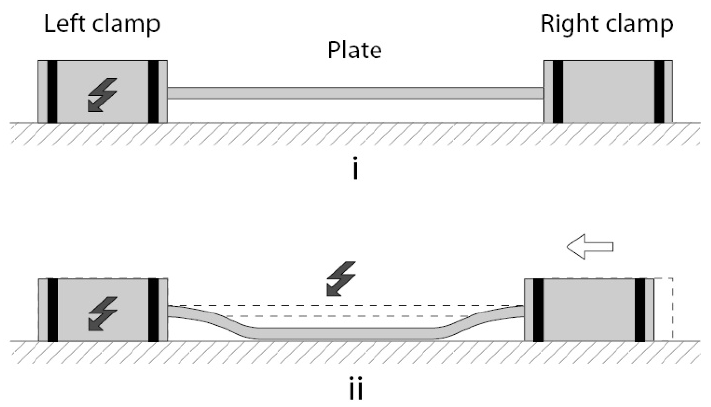
Figure 13. Scratch-drive actuator inchworm-like walking sequence: ( i ) Only the left clamp is activated; ( ii ) a voltage is applied to the plate and causes its inflection. Adapted from [96]. MEMS actuators need higher voltages to generate large displacements; therefore, energy efficiency in the MEMS drives has lower values. Devices with electrostatic scratch actuators require less energy for higher force actuation but require power supplied by RF [97] or substrate [98]